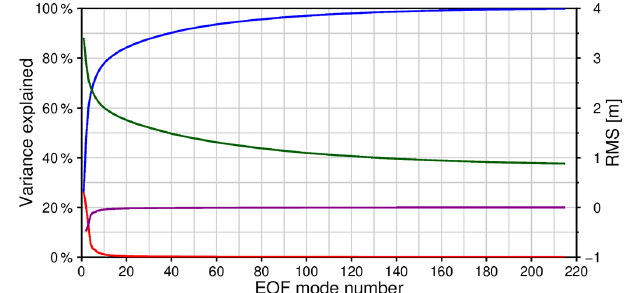
Figure 2. Percentage of variance explained (red line) and cumula- tive variance explained (blue line) by each EOF mode; RMS error (green line) and its derivative (purple line) of the difference between the reconstructed time series of monthly elevation change and that of observation in different